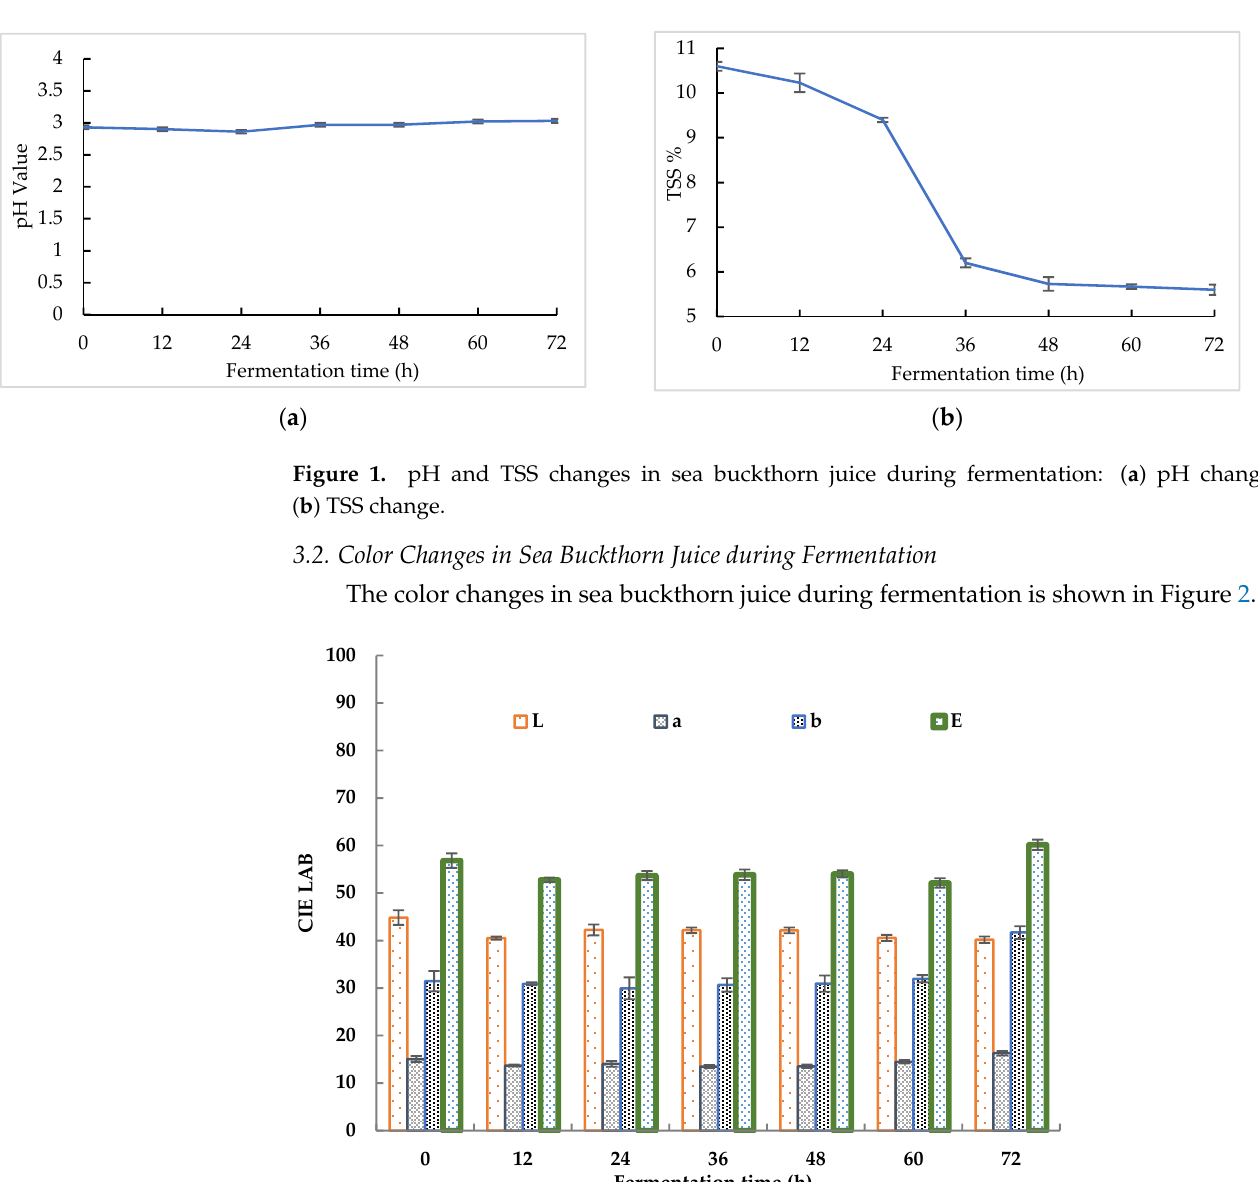
Both S. cerevisiae and Lactobacillus consume a lot of sugar during fermentation, which may have caused the decline in the TSS [26].